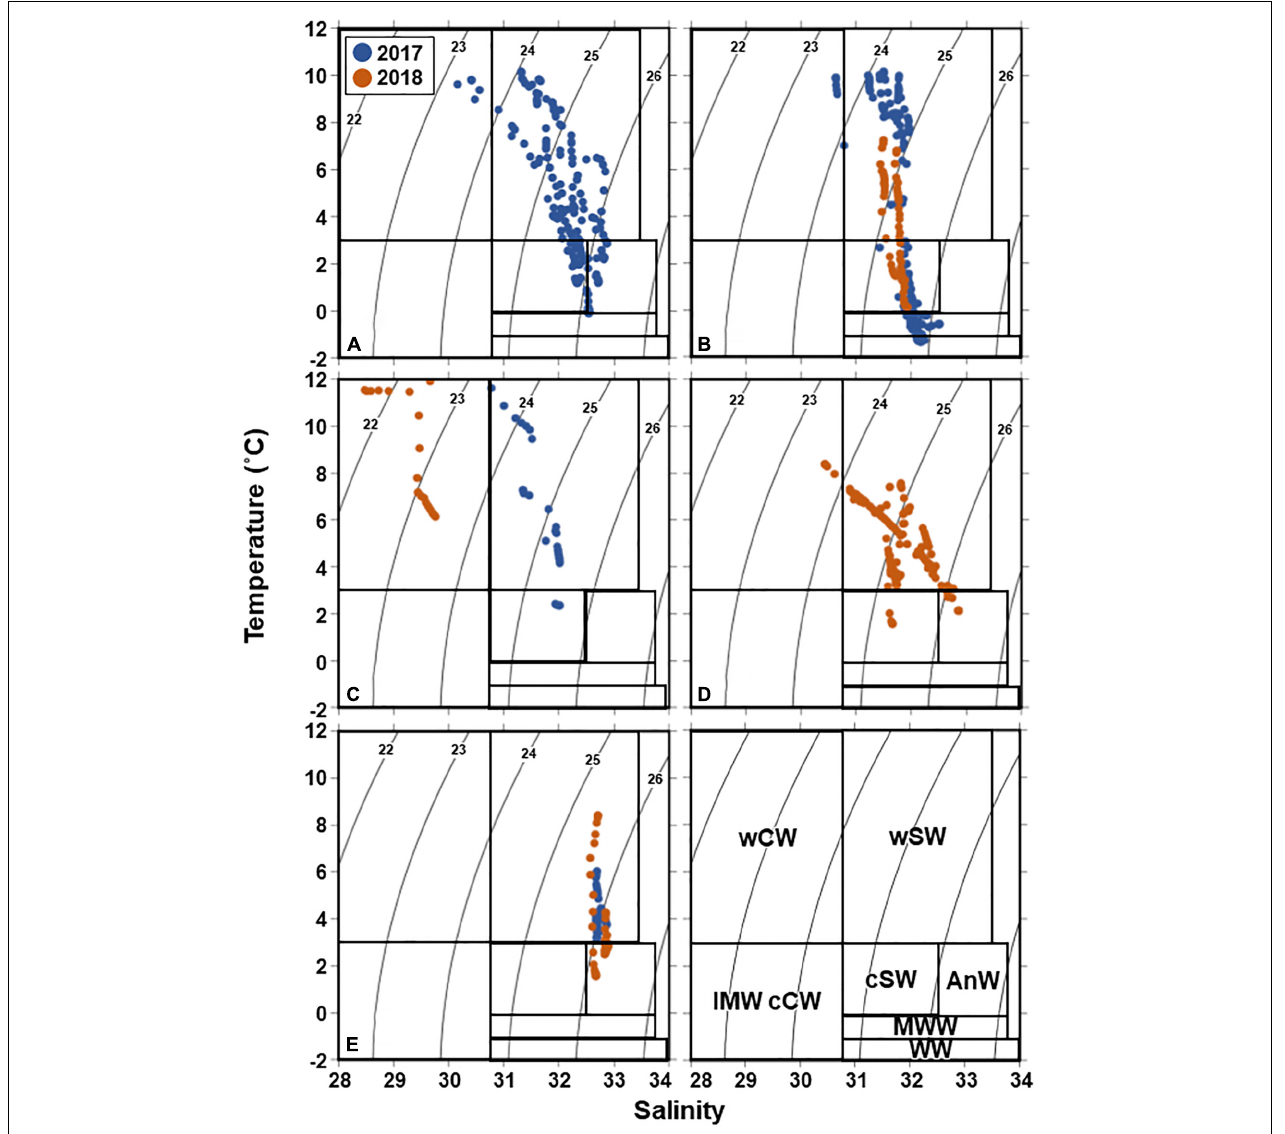
FIGURE 6 | T-S diagram of the five groups (A–E) identified from Bray–Curtis similarity analysis based on zooplankton abundance (cf. Figure 4 ) in the northern Bering Sea during July of 2017 and 2018. The numbers in the panels indicate water density. wCW, warm coastal water; wSW, warm shelf water; IMW cCW, ice melt water and cool coastal water; cSW, cool shelf water; AnW, Anadyr water; MWW, modified winter water; WW, winter water (cf. Danielson et al.,